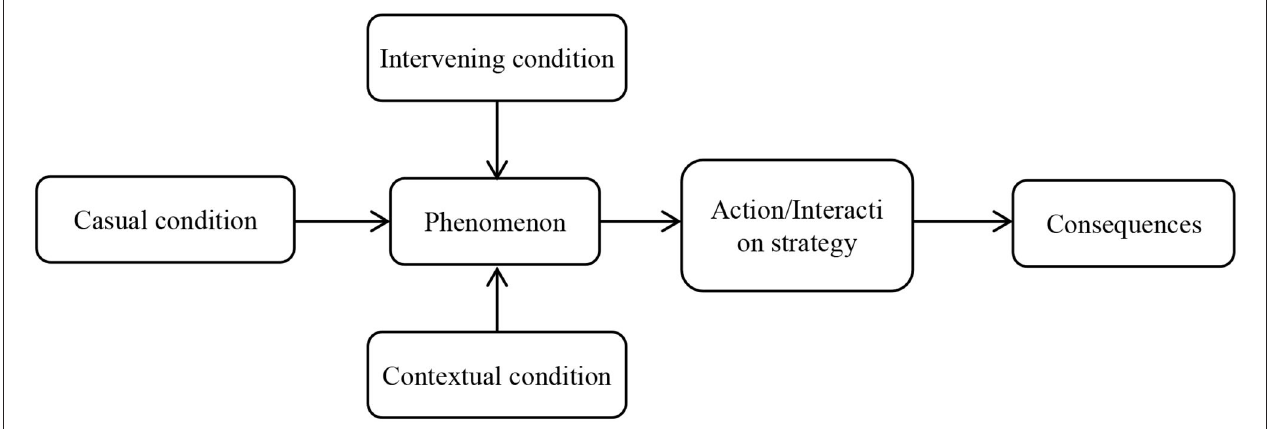
FIGURE 2 | Paradigm model of Strauss and Corbin